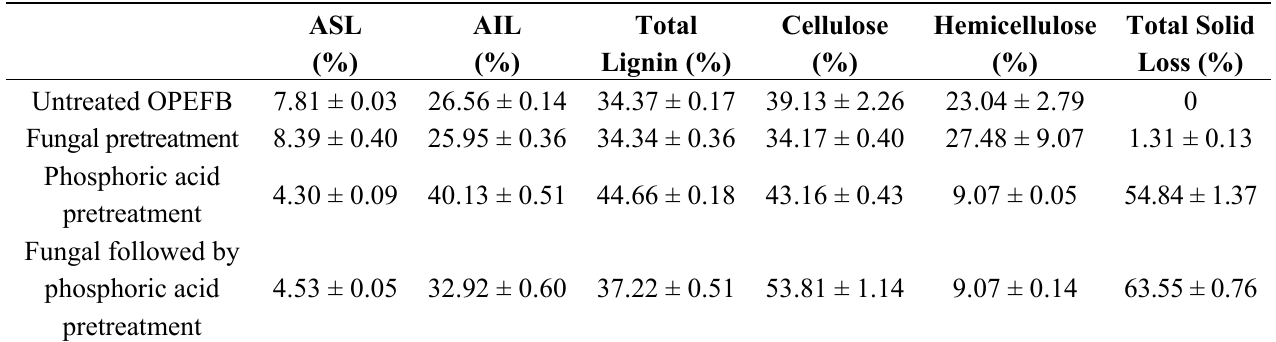
Table 1. Composition of oil palm empty fruit bunches (OPEFB) after